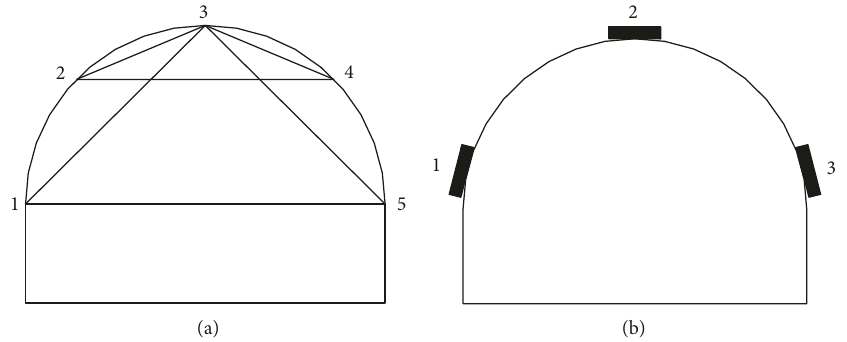
Figure 19: Arrangement of the measuring points: (a) roadway convergence and (b) surrounding rock pressure.